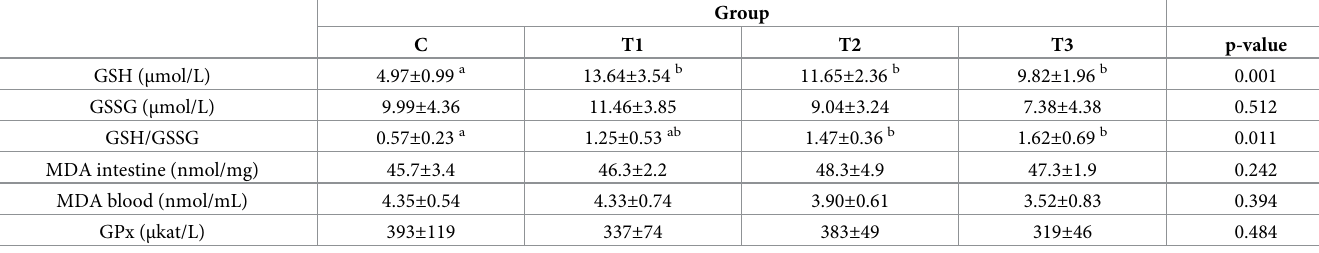
Table 7. Antioxidant status parameters in blood (GSH, GSSG, GSH/GSSG, MDA, GPx) and jejunal mucosa